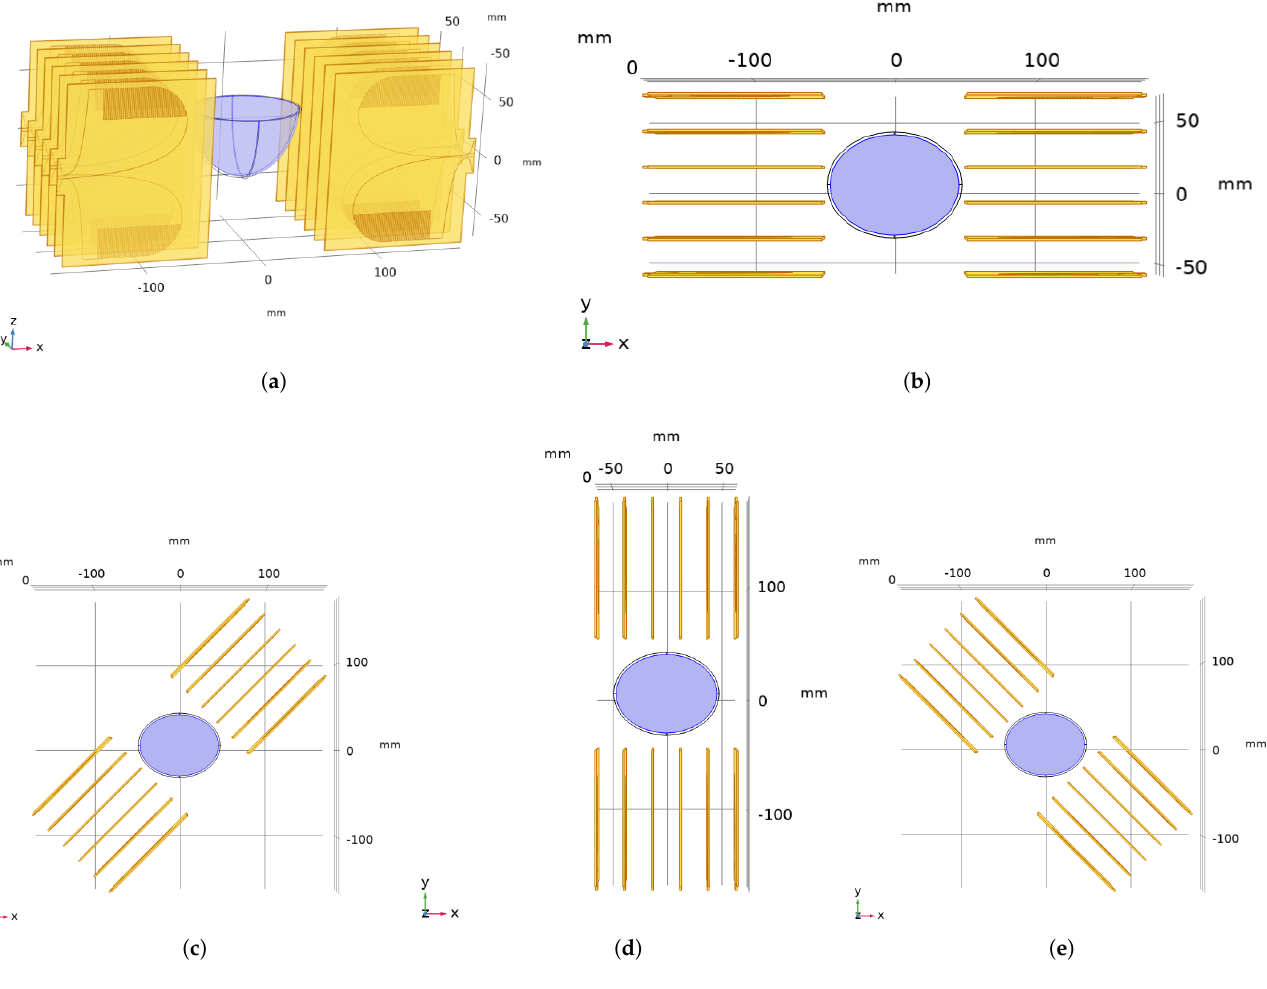
Figure 2. ( a ) Side view of the linear MH applicator with 12 antennas with a rotation angle of θ = 0 ◦ . ( b ) Top view of the linear MH applicator with θ = 0 ◦ . ( c – e ) Top views of the linear MH applicator with θ = 45 ◦ ,90 ◦ , and 135 ◦ ,